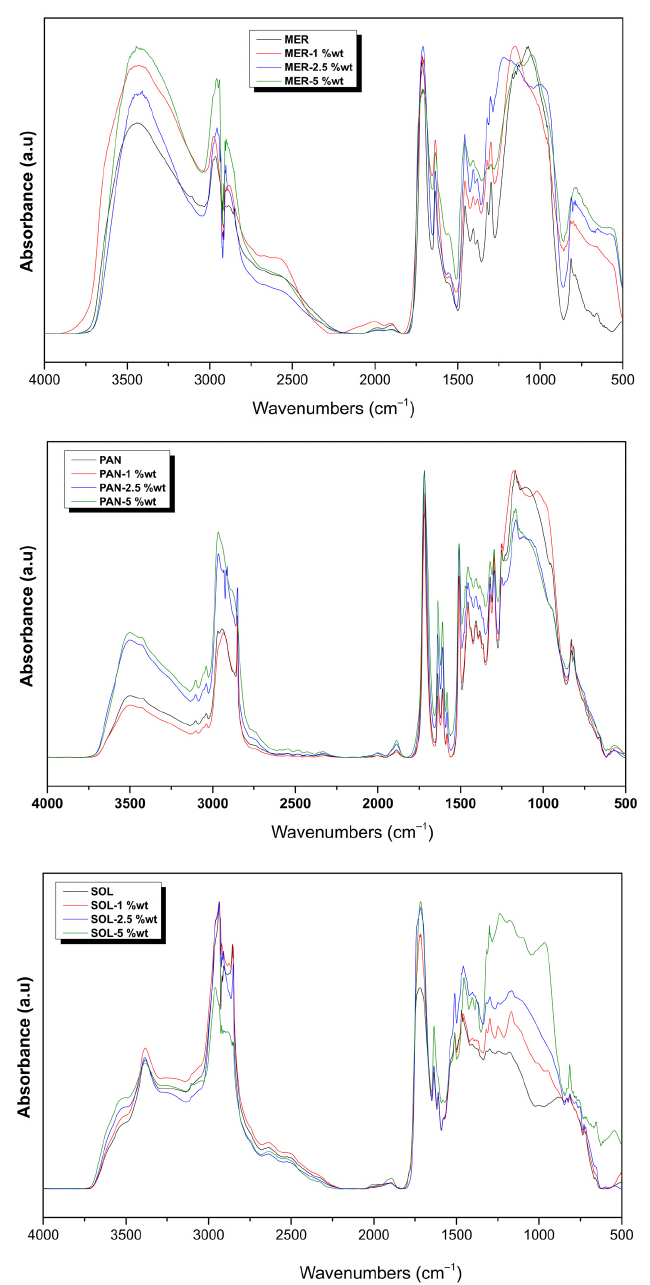
Figure 1. Comparison of the spectra of the three luting cements following the addition of zirconia nanoparticles (ZrO 2 NPs) at all ratios, right after dual polymerization. MER = Meron plus QM, MER-1wt% = Meron plus QM with 1% wt zirconia NPs, MER − 2.5wt% = Meron plus QM with 2.5% wt zirconia NPs, MER − 5wt% = Meron plus QM with 5% wt zirconia NPs, PAN = Panavia SA Universal, PAN − 1wt% = Panavia SA Universal with 1% wt zirconia NPs, PAN − 2.5wt% = Panavia SA Universal with 2.5% wt zirconia NPs, PAN − 5wt% = Panavia SA Universal with 5% wt zirconia NPs, SOL = Solocem, SOL − 1wt% = Solocem with 1% wt zirconia NPs, SOL − 2.5wt% = Solocem with 2.5% wt zirconia NPs, SOL − 5wt% = Solocem with 5% wt zirconia